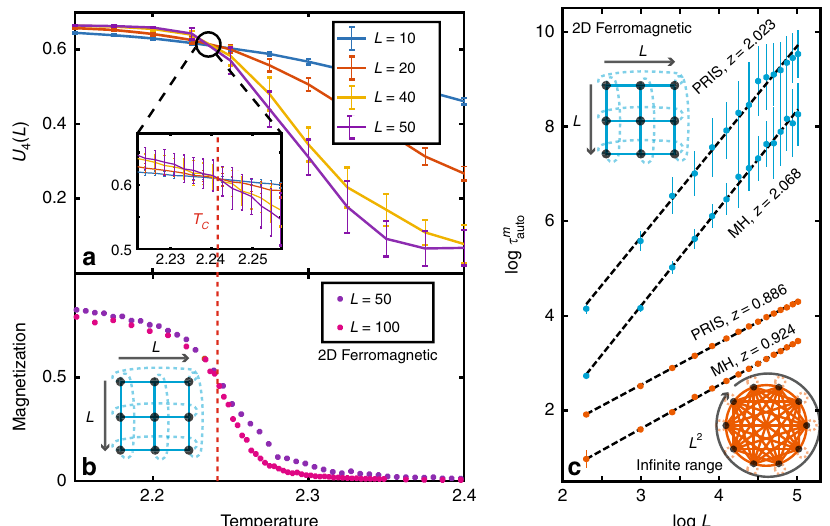
Fig. 4 Detecting and characterizing phase transitions. a Binder cumulants U 4 ( L ) for various graph sizes L on the 2D Ferromagnetic Ising model. Their intersection determines the critical temperature of the model T C (denoted by a dotted line). b Magnetization estimated from the PRIS for various L . c Scaling of the PRIS magnetization autocorrelation time for various Ising models, benchmarked versus the Metropolis-Hastings algorithm (MH). The complexity of a single time step scales like N 2 = L 4 for MH on a CPU and like N = L 2 for the PRIS on a photonic platform. For readability, error bars in b are not shown (see Supplementary Note